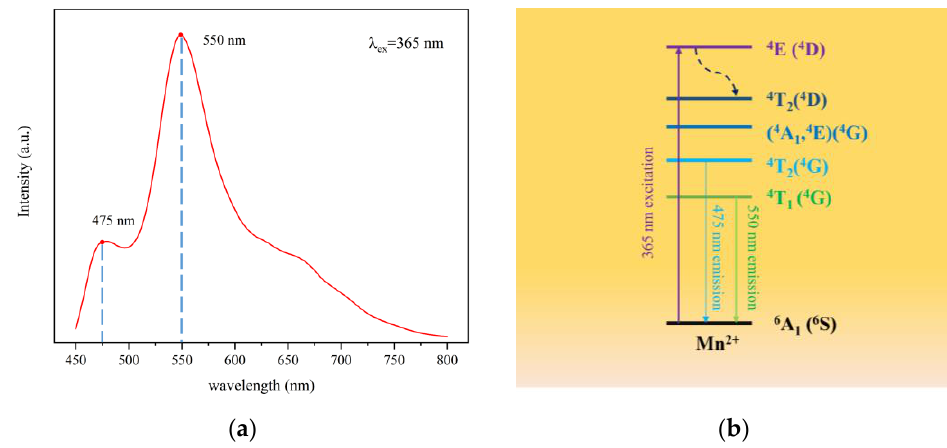
Figure 3. ( a ) The excitation spectrum of CSO:Mn 2+ under light excitation at 365 nm. ( b ) Energy-level transition diagram of CSO:Mn 2+ .